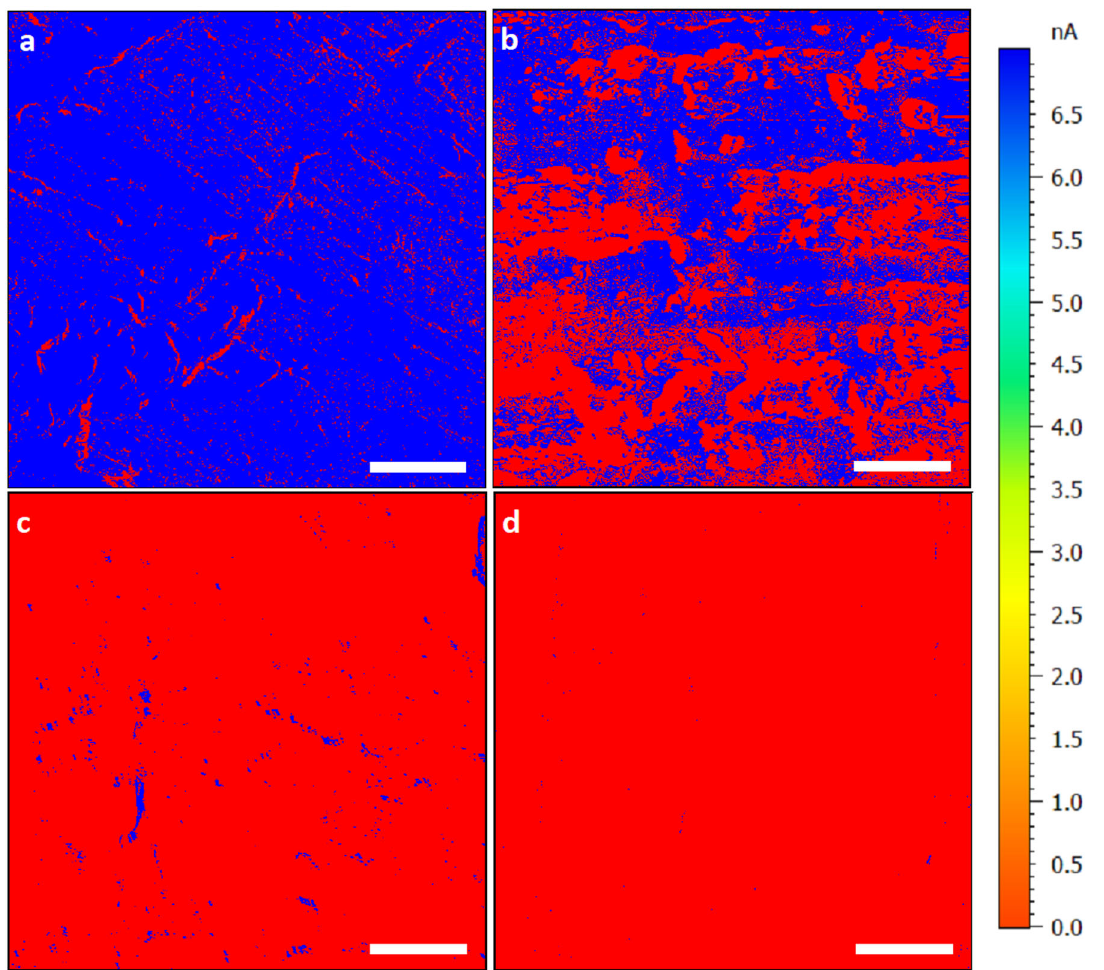
Fig. 2 Conductivity maps at 2 V bias applied to the AFM tip for samples. a Pure Cr with native oxide, b 10C-1.5O, c 10C-12O, and d ECCS. The scale bars in a , b , c , and d indicate 10 μ m.